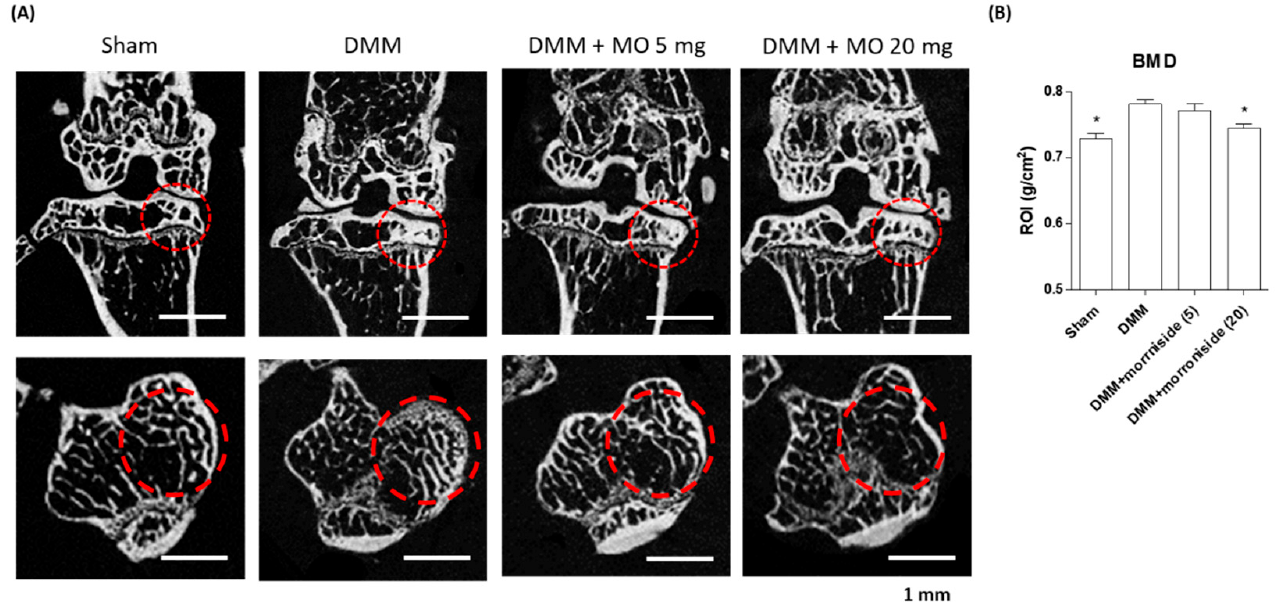
Figure 6. Effect of morroniside administration on DMM-induced osteophyte development. DMM-induced OA mice were treated with morroniside (5 and 20 mg/kg/day) for 10 weeks. ( A ) Representative micro-CT images of mouse knee joints reveal the density of the chondral bone plate. Red circle indicates osteophyte formation in response to inflammatory responses. ( B ) Bone mineral density (BMD) of proximal tibial epiphysis was analyzed using one-way ANOVA (Tukey’s honest significant difference post hoc test, analysis of variance). * p < 0.05 vs. DMM, DMM, destabilization of the medial meniscus; OA, osteoarthritis; CT, computed tomography; Sham; sham-operated, MO; morroniside.